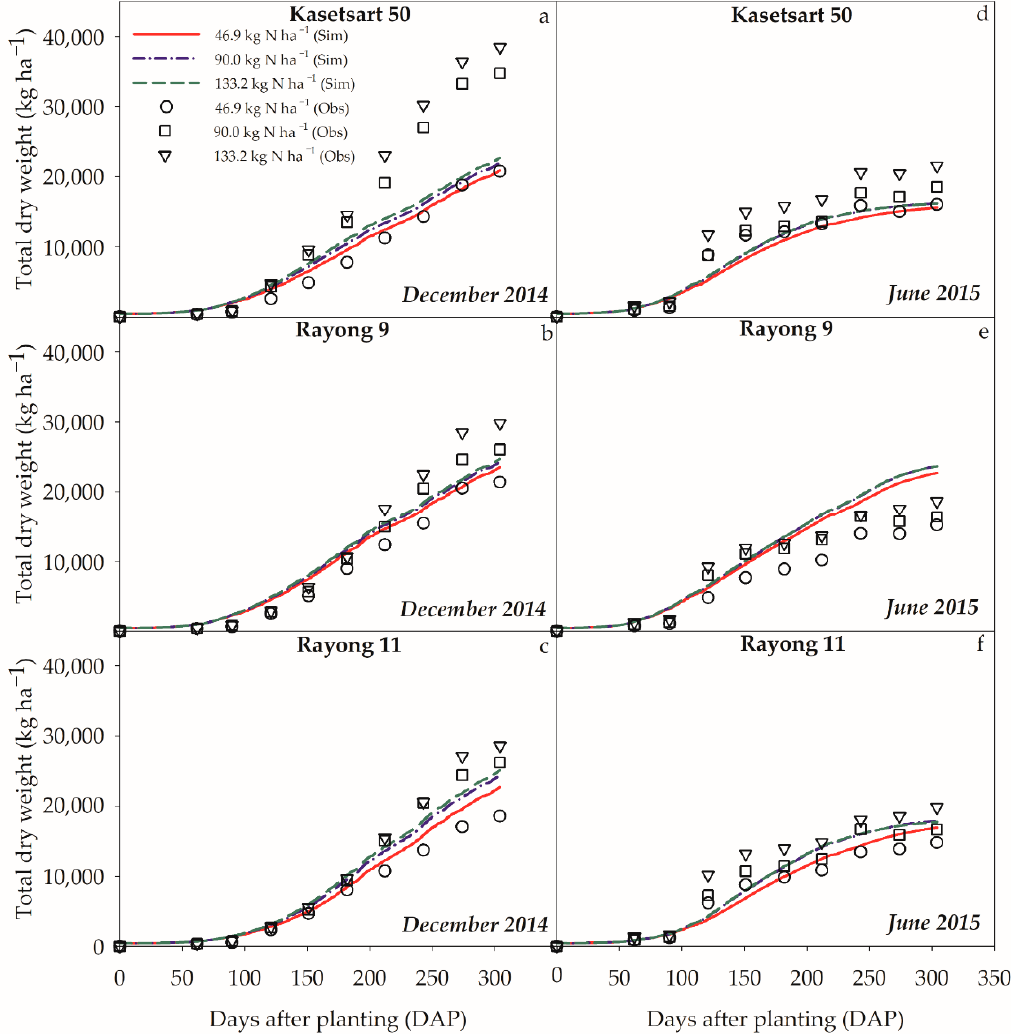
Figure A1. Simulated (Sim) and observed (Obs) total dry weights for Kasetsart 50, Rayong 9, and Rayong 11 genotypes planted under three different rates of nitrogen application on December 2014 ( a – c ), and June 2015 ( d–f ).